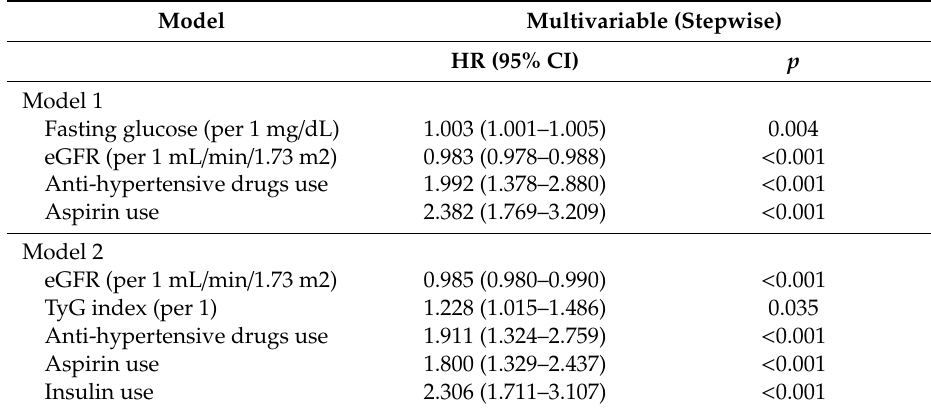
Table 4. Determinants for cardiovascular events using the Cox proportional hazards model (multivariable stepwise analysis) after excluding a history of cardiovascular events ( n =